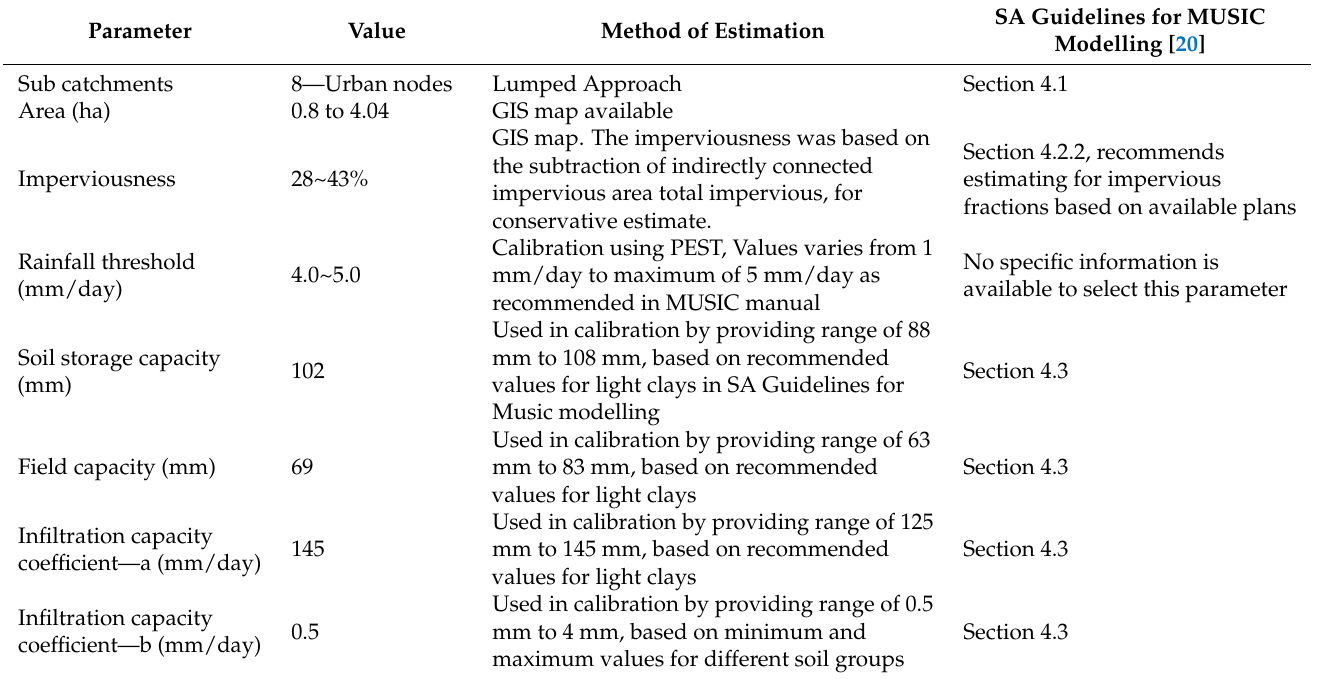
Table 1. The list of parameters adopted to represent the catchment. The reference to relevant section of SA modeling guidelines for MUSIC [20] is also